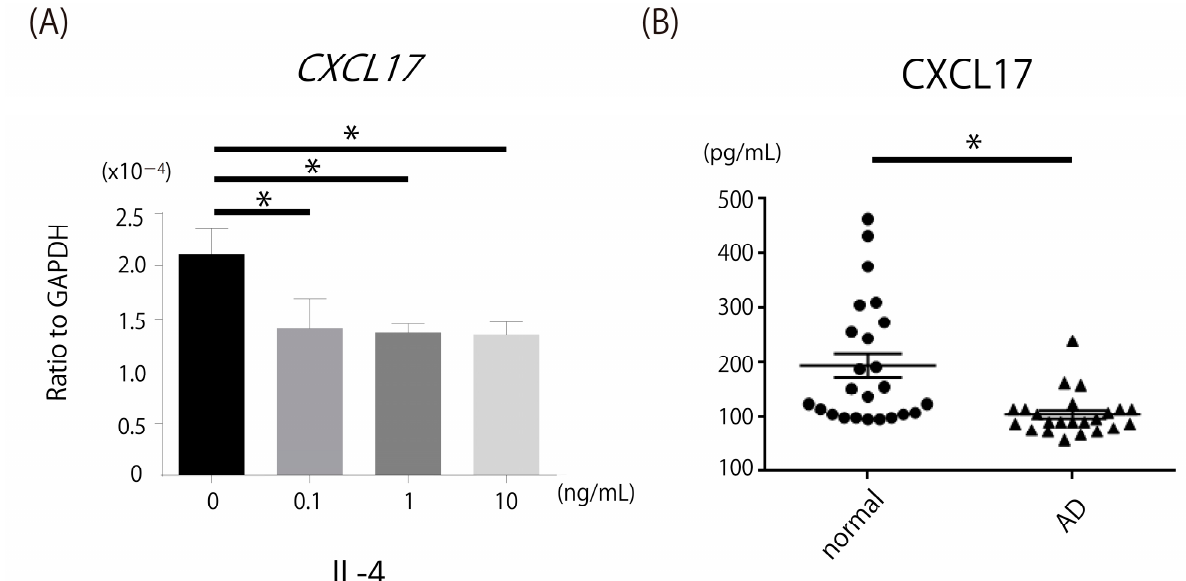
Figure 6. Downregulation of CXCL17 production in IL-4-stimulated normal human epidermal keratinocytes (NHEK) and decreased CXCL17 expression in patients with atopic dermatitis (AD). Expression of CXCL17 mRNA was assessed in NHEK cells treated with IL-4 stimulation. CXCL17 expression levels were evaluated in sera of patients with AD. ( A ) CXCL17 mRNA expression by NHEK was significantly attenuated by IL-4 stimulation. ( B ) Serum levels of CXCL17 in patients with AD were significantly decreased compared with normal controls. * p < 0.05.